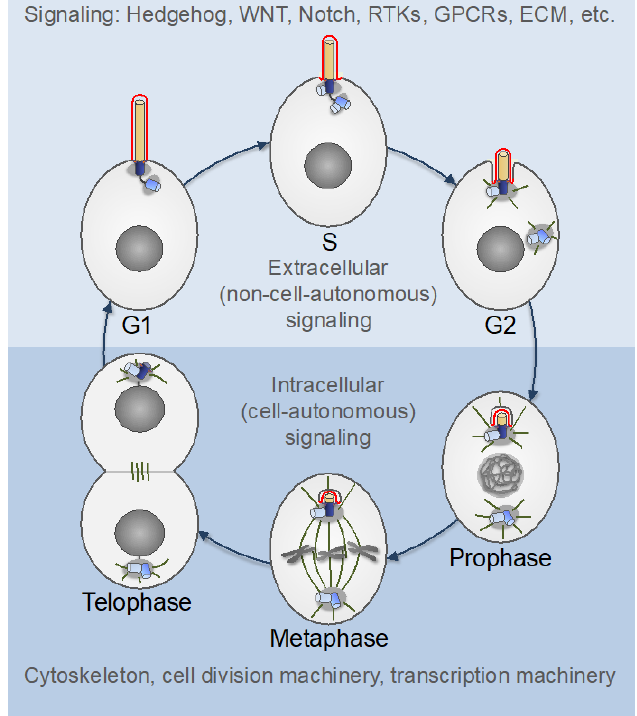
Figure 7. The centrosome cycle in proliferating cells. The primary cilium is formed by the mother centriole-centrosome complex in G1 phase and progressively shortens thereafter. In the interphase (upper part), the primary cilium serves as an “antenna” that senses extracellular cues and relays the signals to the cell’s interior. The ciliary membrane (red) di ff ers in its composition from the plasma membrane and is enriched in specific ion channels and receptors for various extracellular regulatory factors (see Figure 4). After mitotic commitment (G2), the two centrosomes separate, recruit additional PCM components and form microtubule (MT) asters—the nascent spindle poles (centrosome maturation). The mother centrosome internalizes with the primary cilium while retaining the ciliary membrane, which may act as a cell fate determinant. The ciliary disassembly completes at the end of mitosis, although the timing may di ff er between cell types [208,211,214,216]. WNT: wingless-type MMTV integration site family; RTKs: receptor tyrosine kinases; GPCRs: G protein-coupled receptors; ECM: extracellular